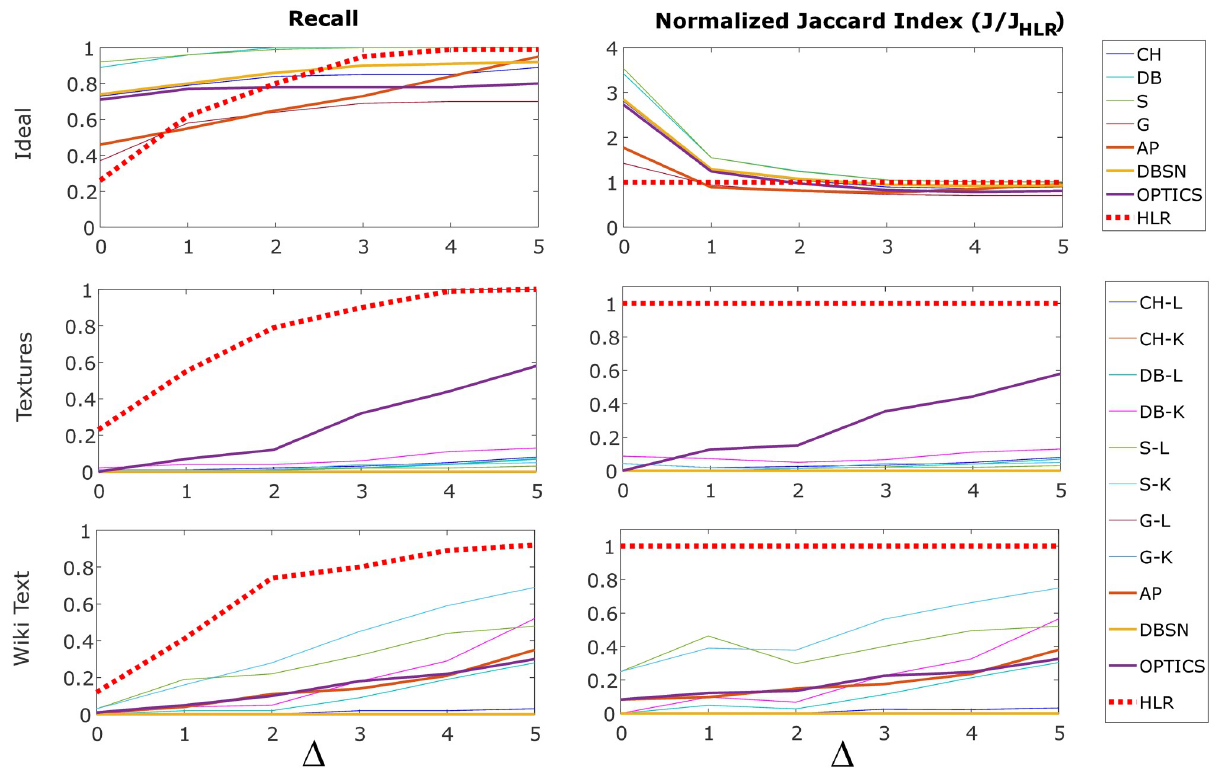
Fig 9. Quantifying performance (recall and normalized Jaccard index) for single cluster number scenario ( ^ y ¼ 15 ). The upper, mid and lower plots pertain to results for ideal reference data, texture image data, and Wikipedia embedded text data, respectively. Values of recall and normalized Jaccard index are plotted with respect to the estimate being within Δ of the ground truth number of clusters ( ^ y ¼ 15 ). Model abbreviations: Calinski-Harabasz (CH); Davies-Bouldin (DB); Silhouette (S); Gap (G); Affinity Propagation (AP); DBSCAN (DBSN); OPTICS (same); HLR (hierarchical linkage regression); linkage clustering (-L); k-means clustering